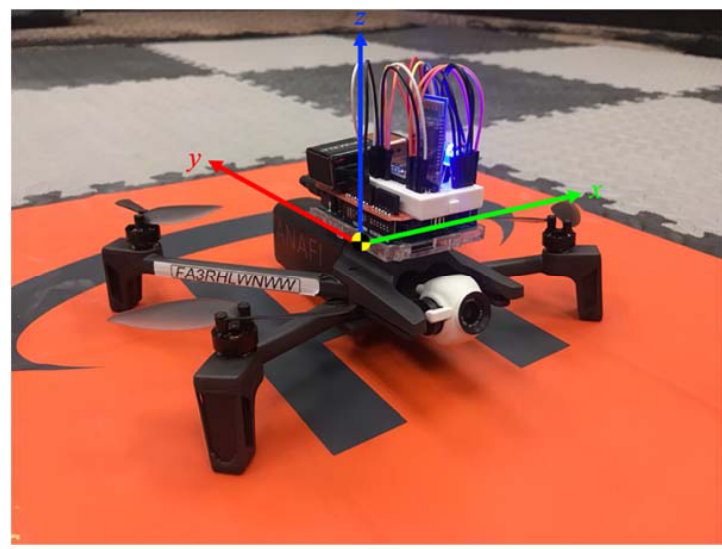
Figure 6. Quadcopter and Hardware System Coordinate System.